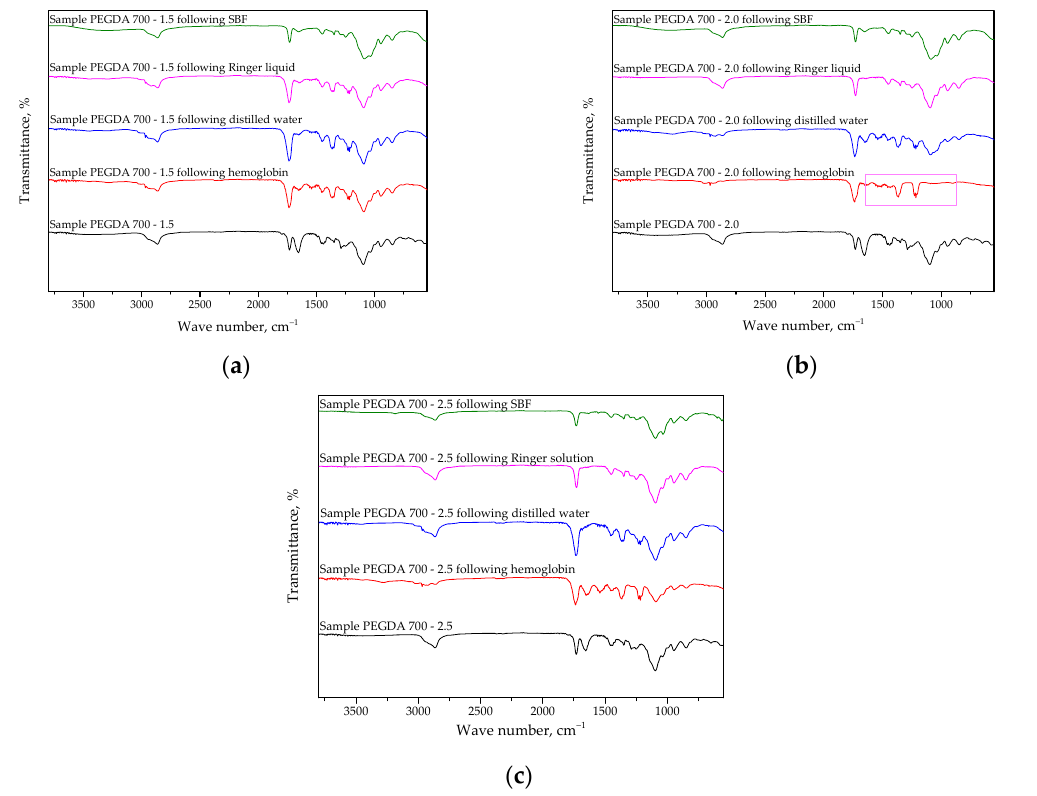
Figure 7. FT-IR spectra showing the influence of incubation on the structure of hydrogels obtained using varying amounts of PEGDA 575, i.e., 1.5 mL ( a ), 2.0 mL ( b ) and 2.5 mL ( c ).